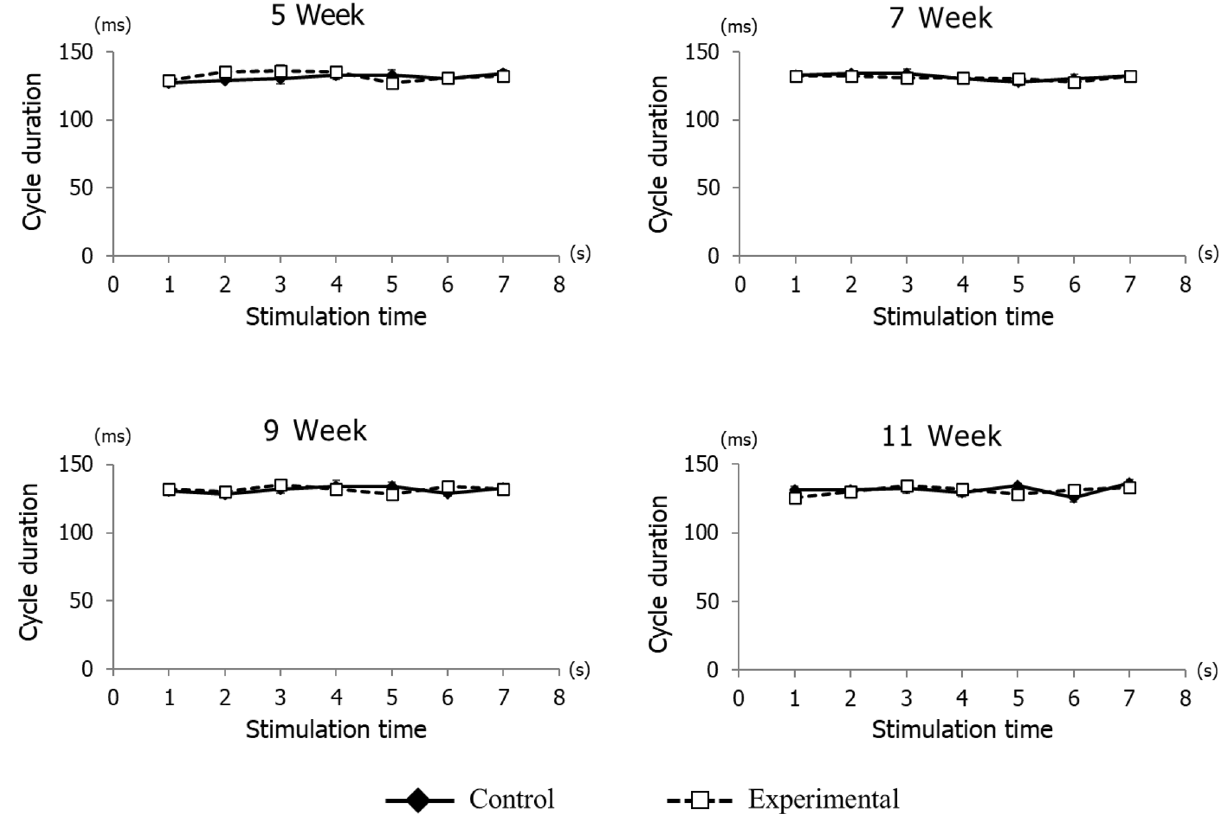
Figure 7. Rhythm of jaw movement cycle duration during repetitive stimulation at each time point. Rhythm of cycle durations was not significantly different in either group during repetitive stimulation per second.